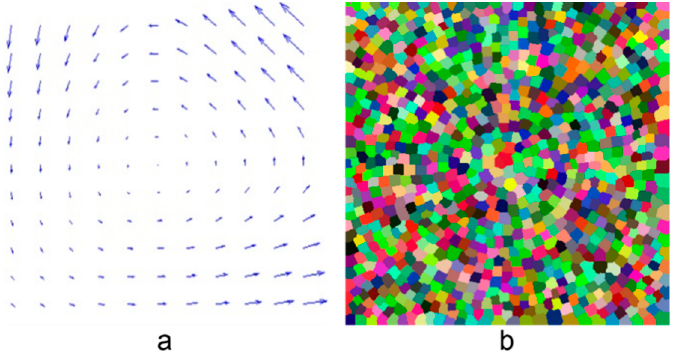
Figure 12. Centroidal Voronoi diagram with vector field: ( a ) vector field; ( b ) centroidal Voronoi diagram with the vector field shown in ( a ) based on the Chebyshev distance metric.